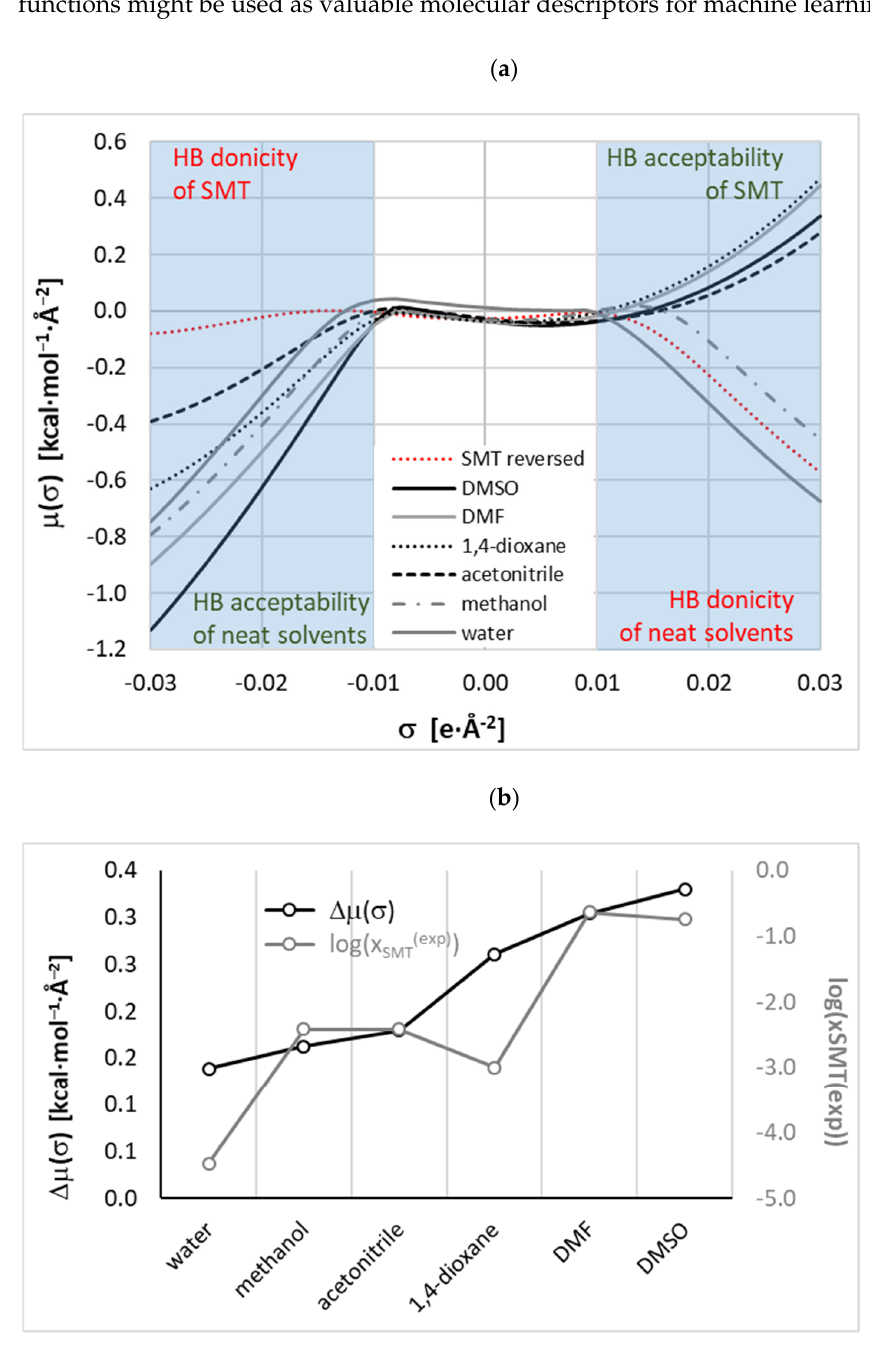
Figure 3. ( a ) Distributions of σ -potentials, μ ( σ ), as a function of charge density, σ , for six neat solvents and SMT at room temperature. Trend of the solute was presented in the reversed form. ( b ) Qualitative correspondence between solubility (gray lines and right axis) and TA index for studied systems.